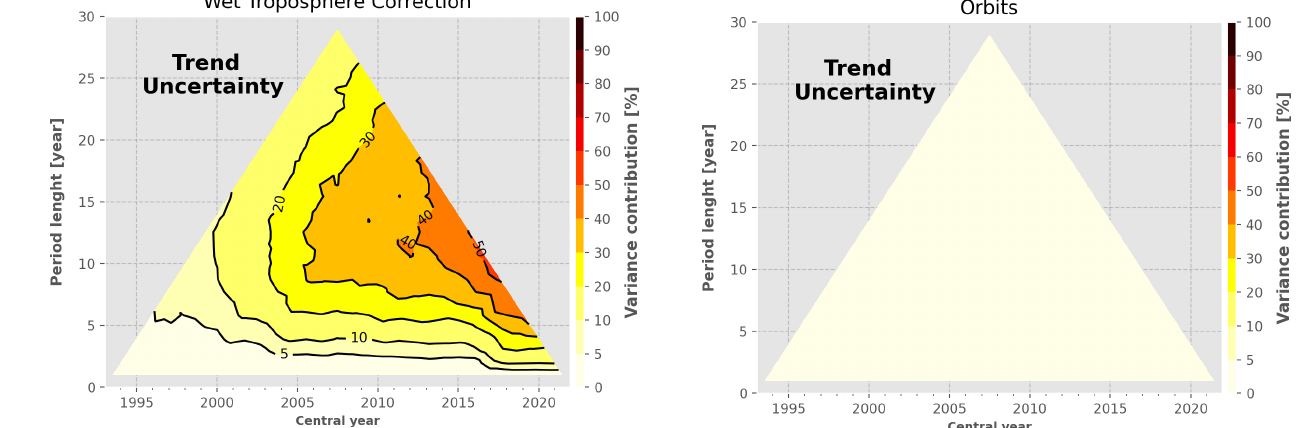
Figure A4. Variance contribution to the GMSL trend variance of the orbit solutions.